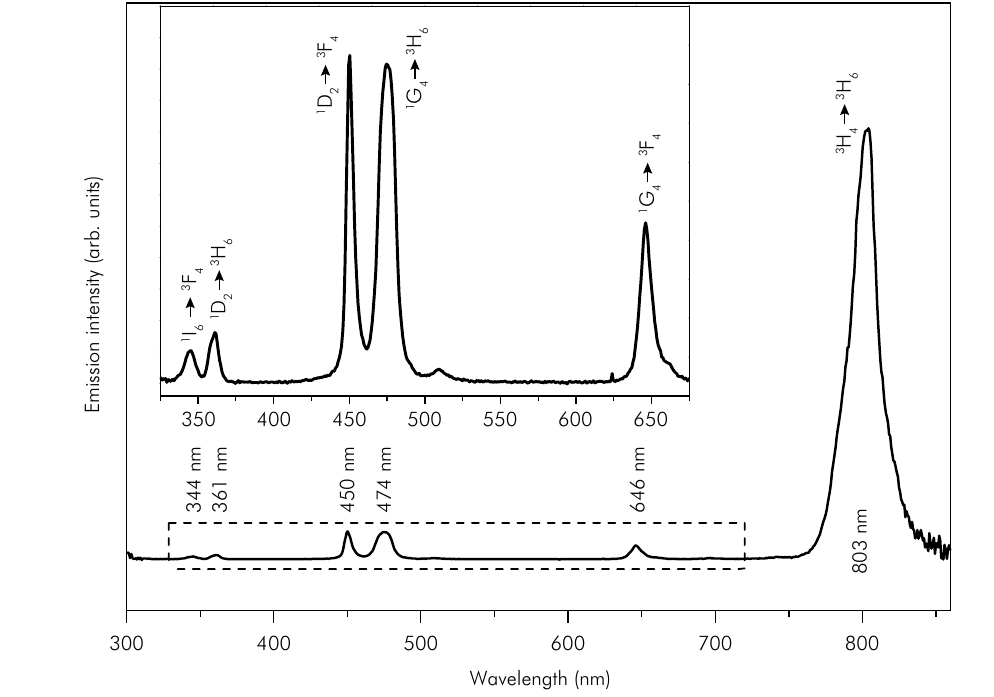
Figure 5. Emission spectrum of the b-NaYF 15 seconds acquisition time. Notice peaks at 450 nm ( 1 D an energy transition.) and 474 nm ( 1 G